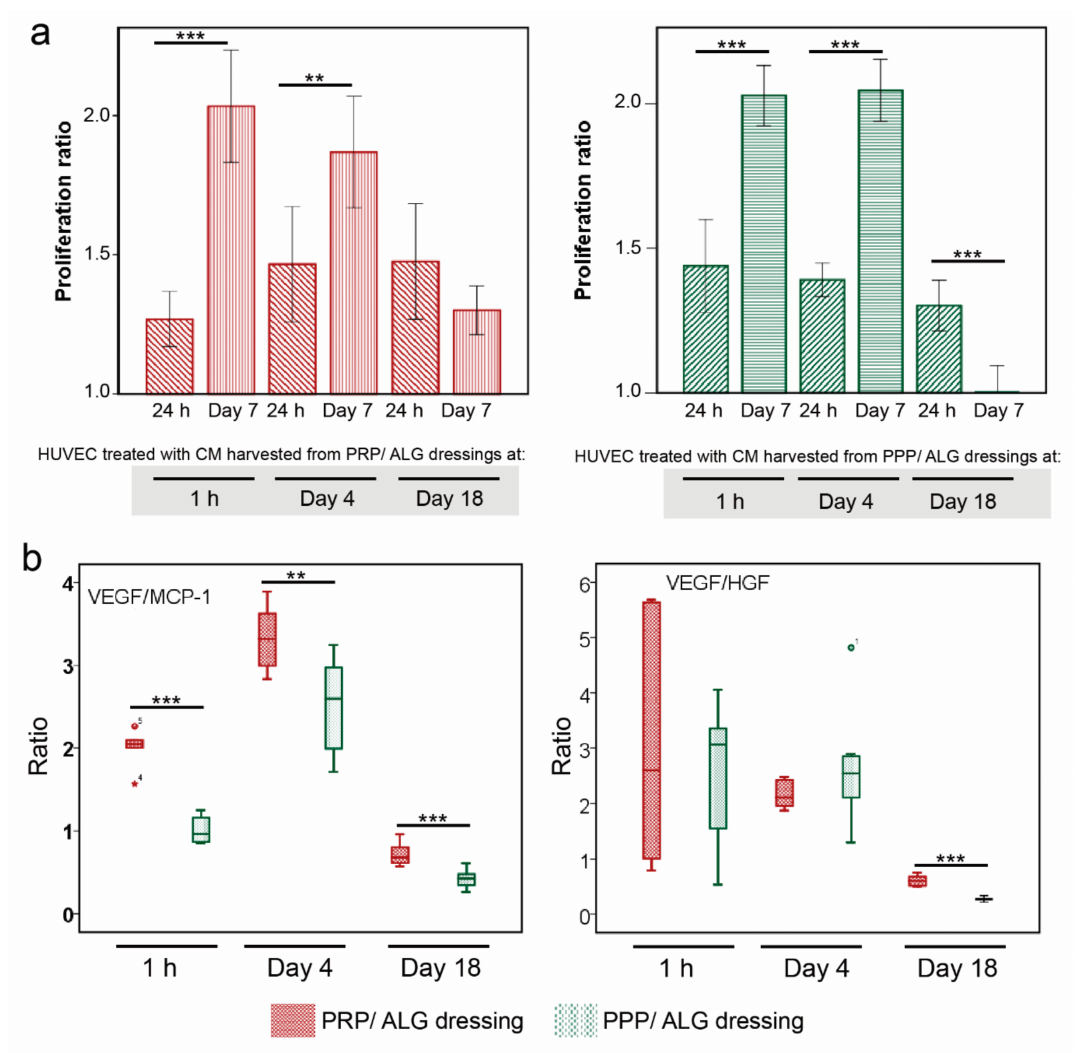
Figure 8. Effects of CM (1 h and days 4 and 18 after bioprinting) on HUVEC proliferation. ( a ) HUVEC-proliferation ratios after 24 h and 7 days of treatment with CM obtained from PRP/ALG and PPP/ALG dressings. OD values were normalized to those for control HUVECs, which were cultured under the same conditions in the absence of CM. ( b ) Box plots showing differences in the median and 25th and 75th percentiles of VEGF/MCP-1 (right) and VEGF/HGF (left) ratios between PRP/ALG and PPP/ALG dressings over time (1 h and days 4 and 18). ** p < 0.01; *** p < 0.001. CM, conditioned media; HUVEC, human umbilical vein endothelial cell; OD, optical density; ALG, alginate; PRP, platelet-rich plasma; PPP, platelet-poor plasma; VEGF, vascular endothelial growth factor; HGF, hepatocyte growth factor; MCP-1, monocyte chemotactic protein